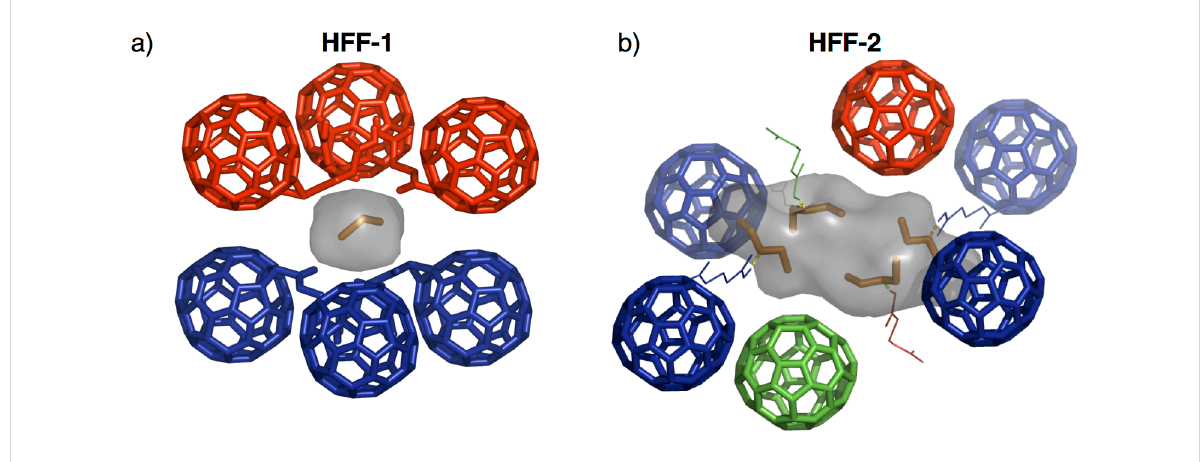
Figure 2: a) Small cavities within the octahedral sites of HFF-1 filled with one CH 2 Cl 2 molecule [57]; b) isolated cavities containing four Et 2 O mole- cules for HFF-2 (void spaces are indicated as grey surfaces and most side arms are omitted for clarity, images are created with PyMOL [58]).